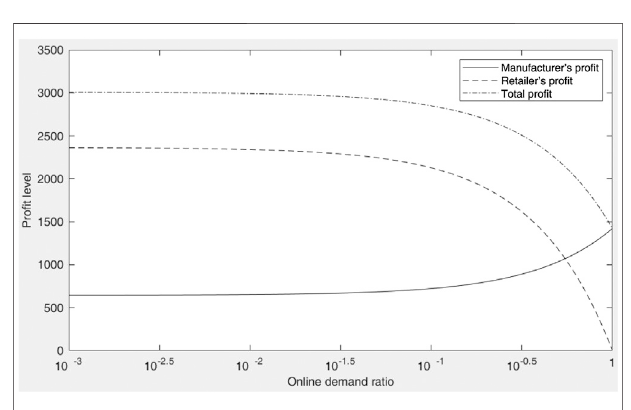
FIGURE 3 | Pro fi t